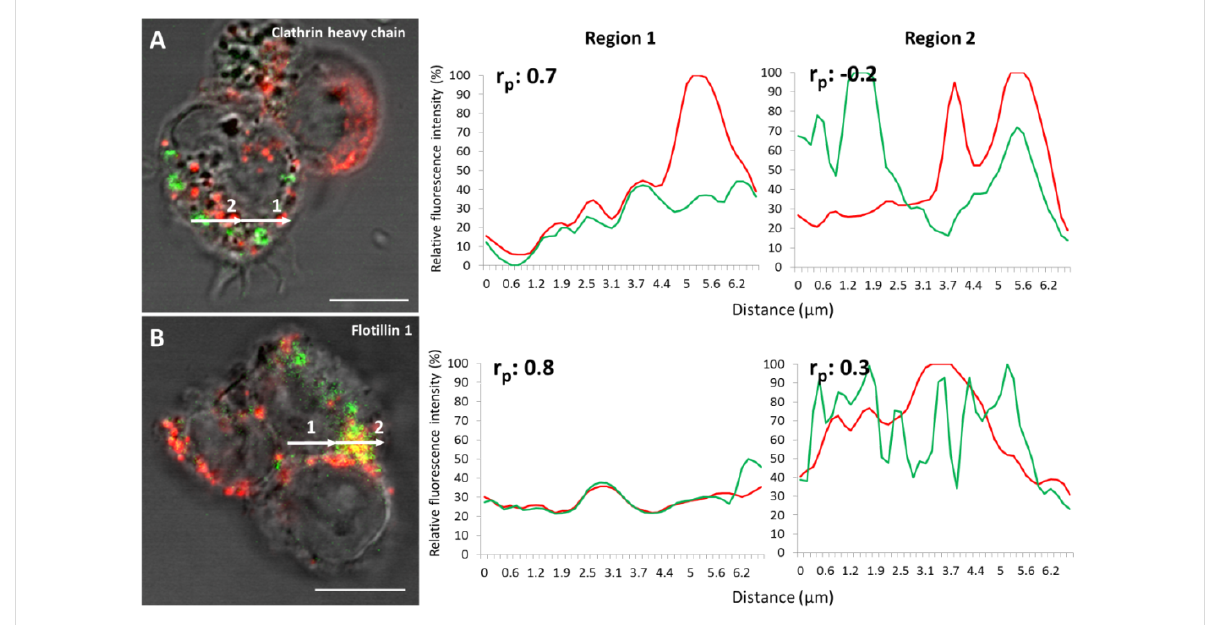
Figure 4: Fluorescence intensity profiles of J774A.1 cells, 40 nm PS NPs with clathrin heavy chain or flotillin-1. (A) and (B) are confocal images of J774A.1 cells treated with 40 nm PS NPs (red) and primary antibodies against uptake proteins (green), respectively. The corresponding relative fluo- rescence profiles of the overlapping signals are shown in the diagrams to the right (regions 1 and 2). Cells are shown in the transmission light channel. The Pearson coefficient (r p ) was calculated for each of the regions. (A) 40 nm PS NPs and clathrin heavy chain, (B) 40 nm PS NPs and flotillin-1. The white arrows are 6.8 µm in length. Scale bar = 10